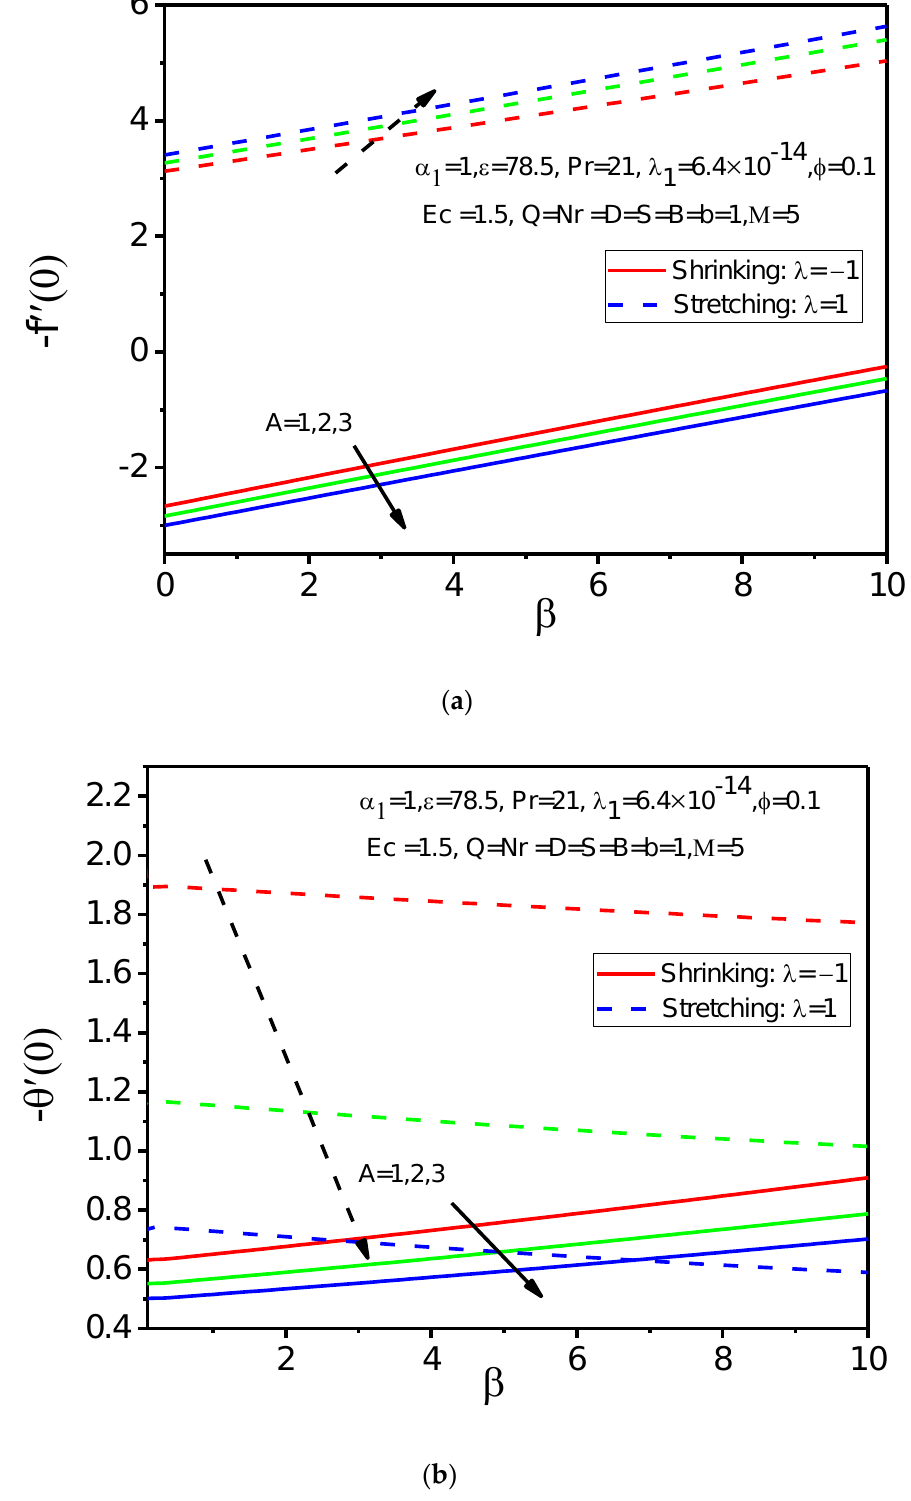
A Figure 17. Influence of against  on ( a ) Skin friction coefficient, ( b ) Rate of heat transfer. Figure 17. Influence of A against β on ( a ) Skin friction coefficient, ( b ) Rate of heat